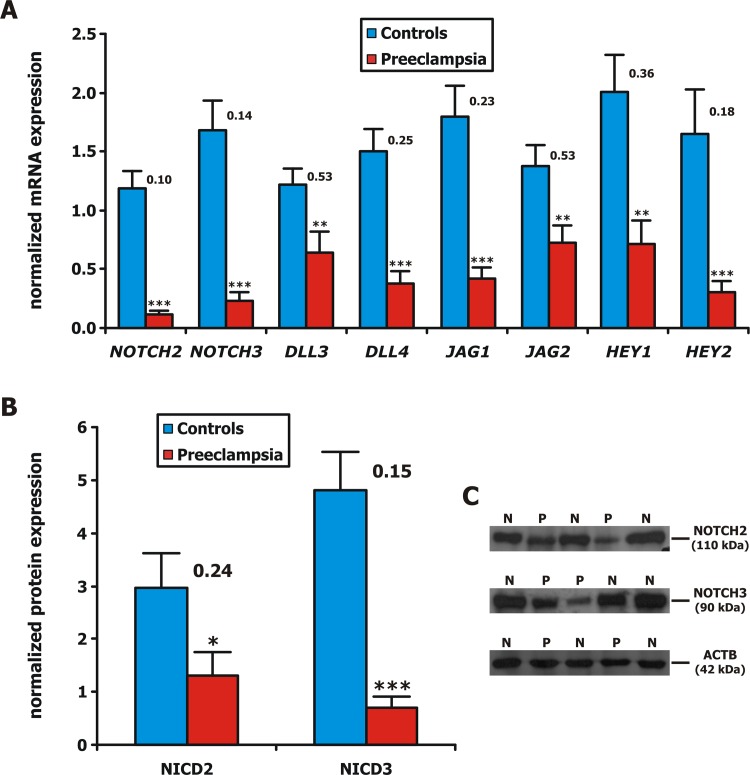
Bar chart depicting Notch pathway members normalized (A) mRNA and (B) protein expression in normal and preeclamptic (PE) late preterm and term placentas, respectively.Floating numbers represent fold change between the two sample groups. Asterisks represent statistically significant associations between PE and controls (*: p<0.05; **: p<0.01; ***: p<0.001). Error bars depict standard error of the mean (SEM). (C) Representative Western blots of NICD2 and NICD3 proteins, along with β-Actin (ACTB) housekeeping gene (N: Controls; P: Preeclampsia).